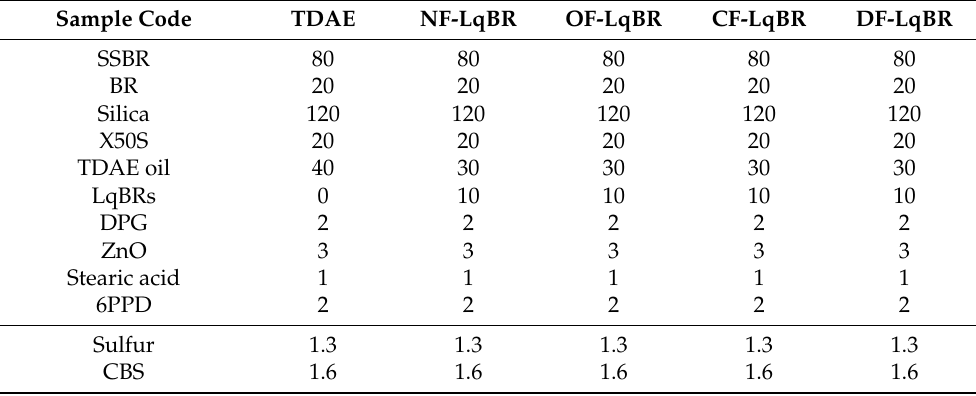
Table 2. Formulation of the rubber/silica compounds using processing aids (unit: parts per hundred rubber, phr).